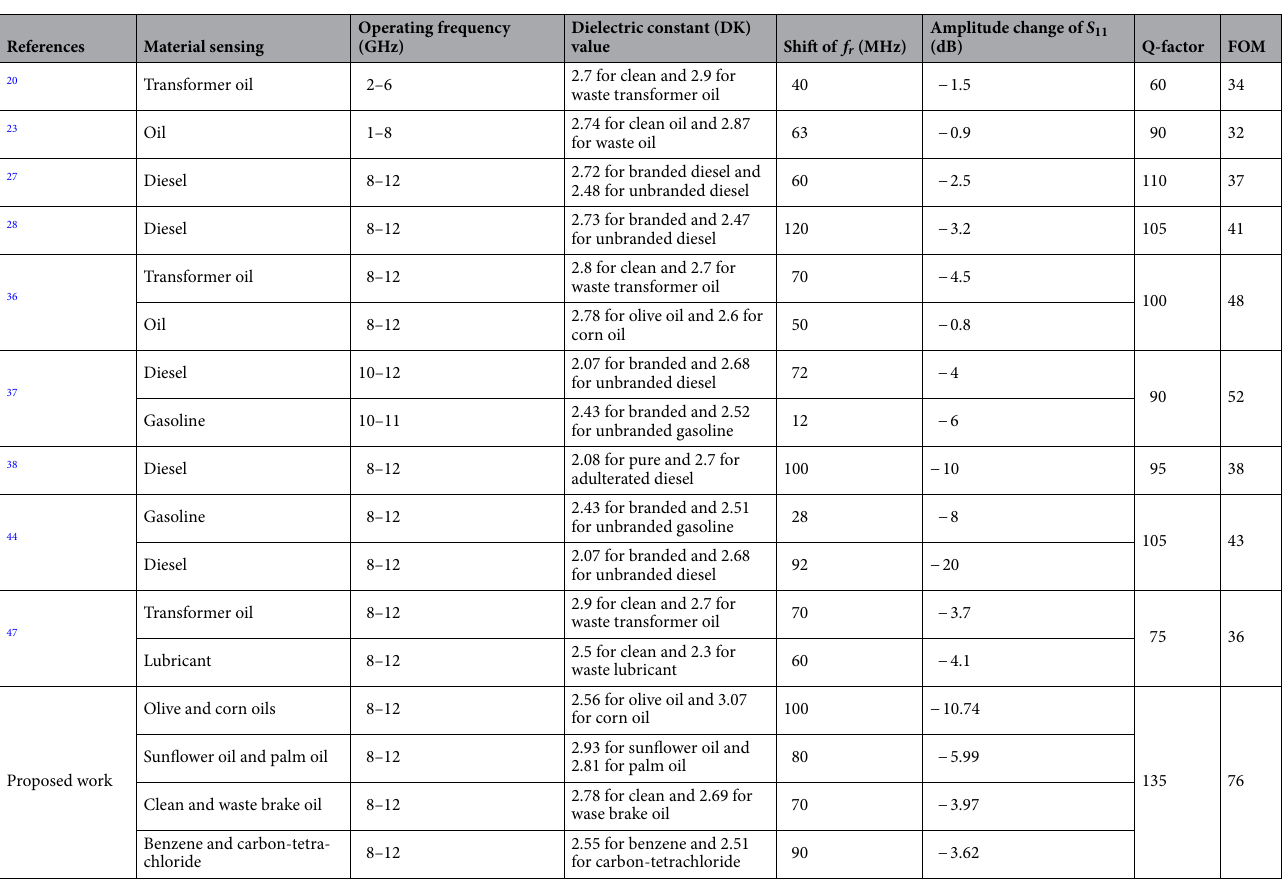
Table 2. A comparison study between the proposed MTM sensor and others was reported in the